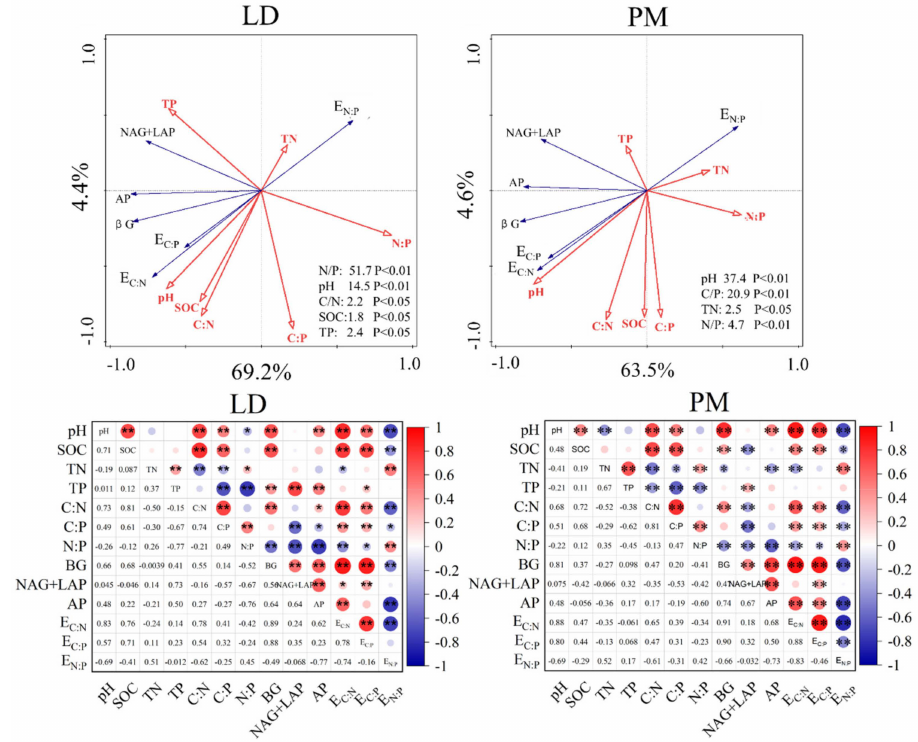
Figure 6. Redundancy analysis of soil physical and chemical properties and soil enzyme activities under different nitrogen application levels of PM and LD treatments. * p < 0.05, ** p < 0.01.PM, plastic film mulching; LD, no film